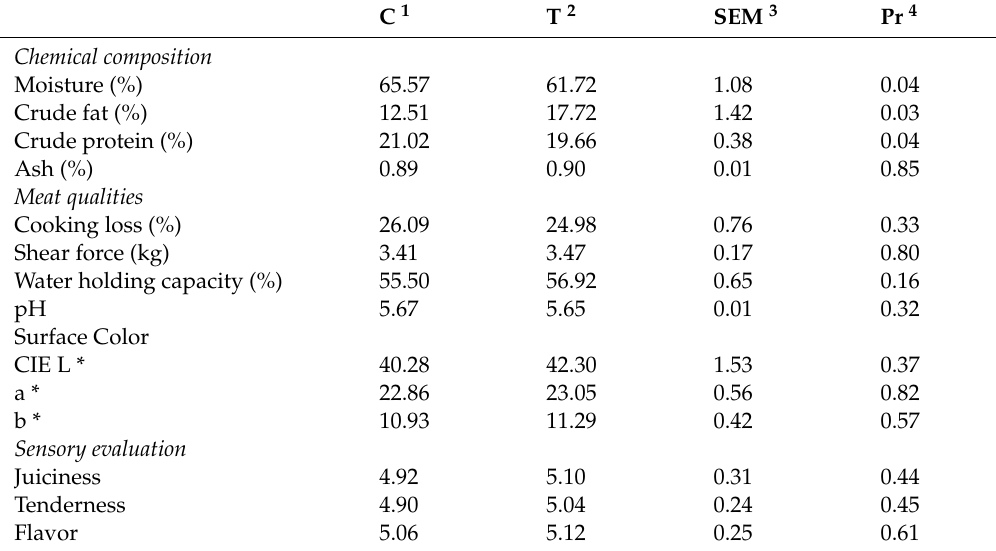
Table 5. Chemical composition and meat qualities of Hanwoo steer fed whole-crop barley silage (WCBS) /